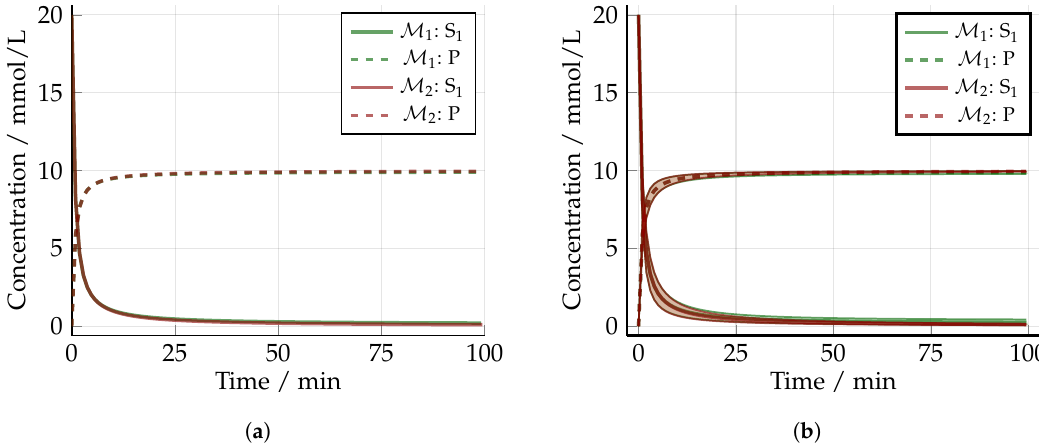
Figure 5. Measured states before applying the MBDoE approach. ( a ) Output trajectories neglecting parameter uncertainties; ( b ) Confidence intervals due to parameter uncertainties.